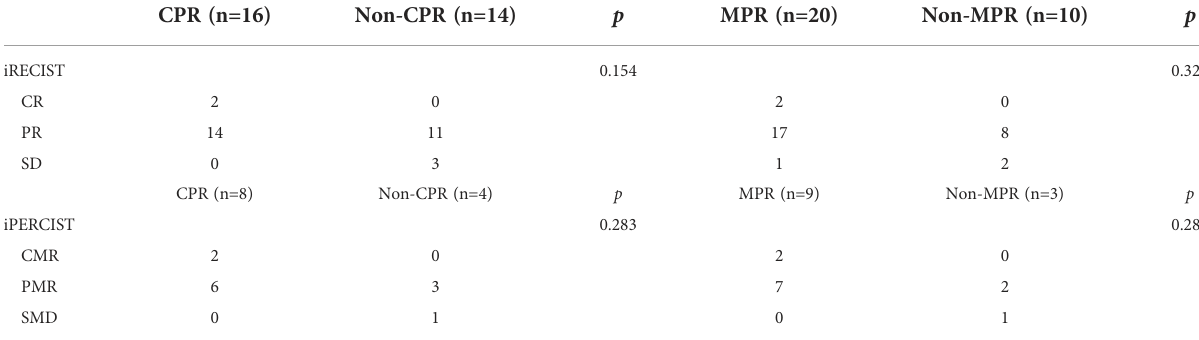
TABLE 4 Association between radiologic response, metabolic response, and pathological response.